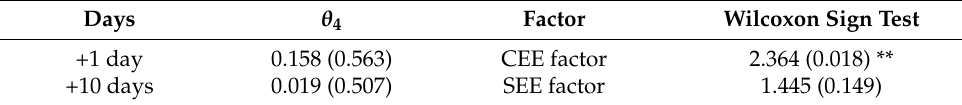
Table 3. Volatility reaction results to Brexit.